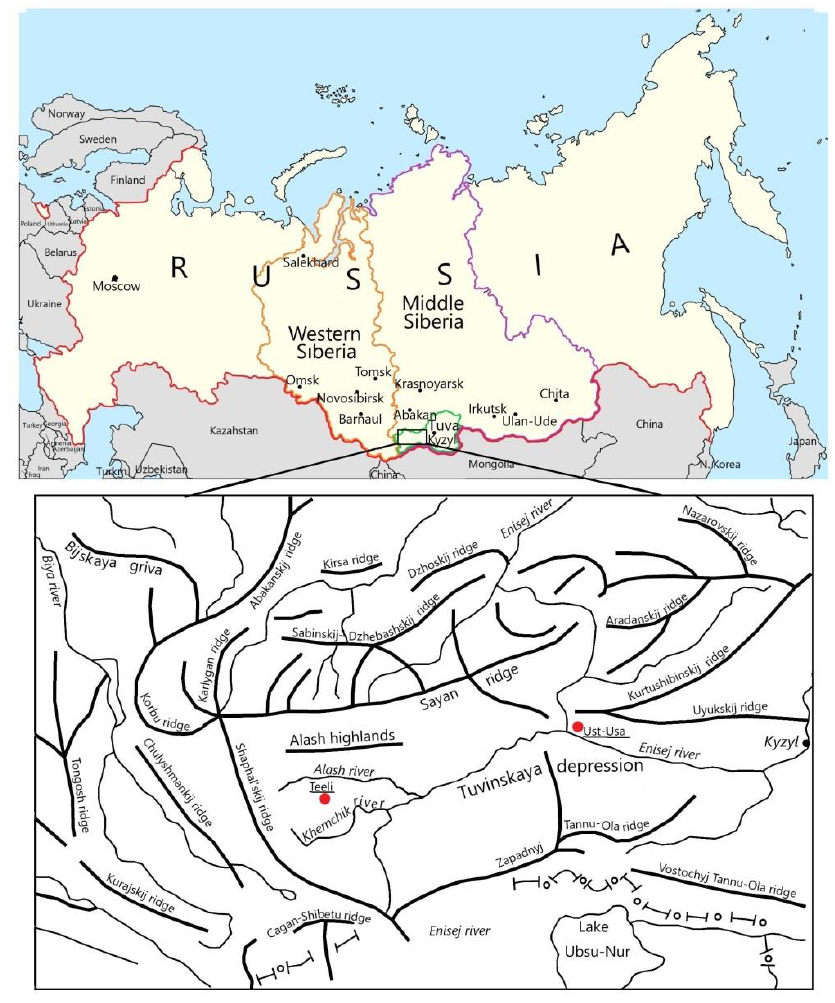
Figure 1. Location of study site at the map of administrative regions of Russian Federation; and the orographic scheme of the Republic of Tuva. The red dots depict the location of meteorological stations.